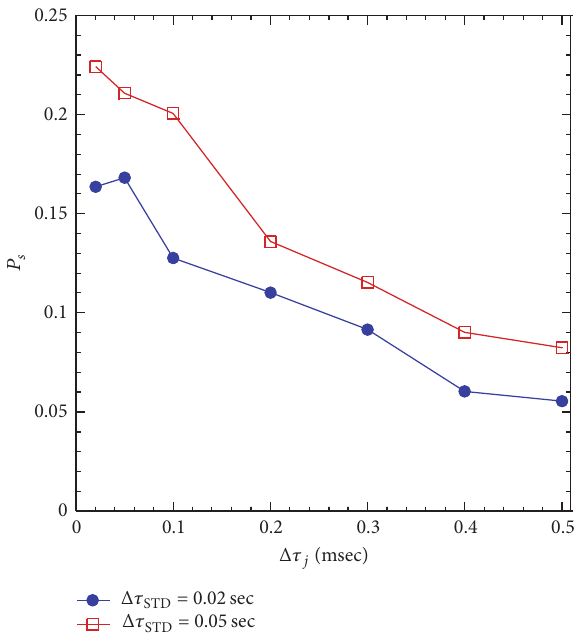
Figure 16: Appearance probability ( 𝑃 𝑠 ) of 𝜆 󸀠 𝐵 ≥ 0.0028 as a function of Δ𝑡 𝑗 .